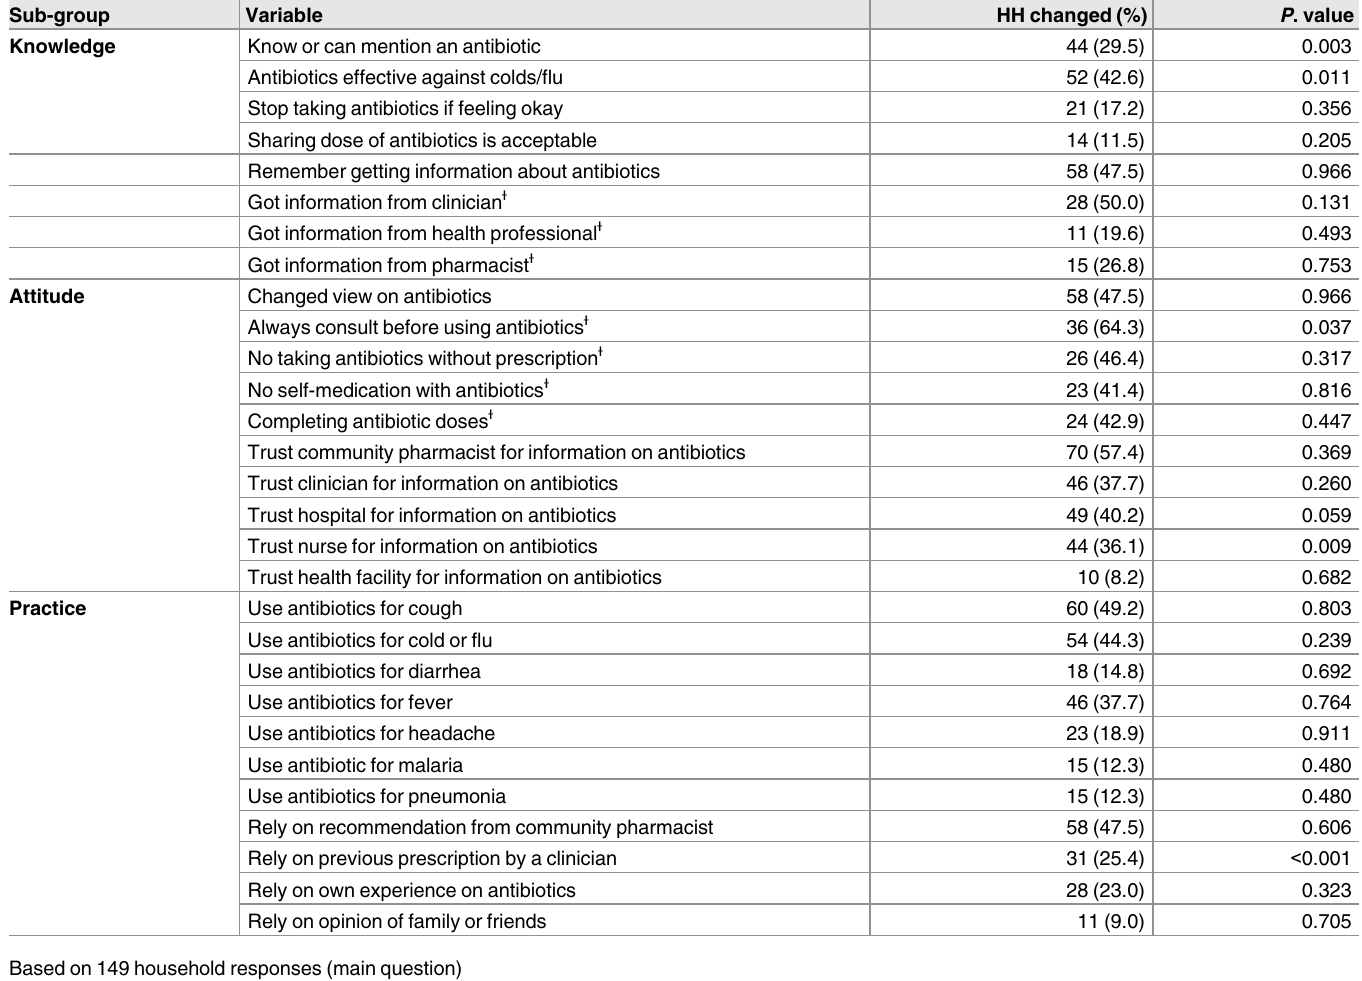
Based on 149 household responses (main question) Ɨ based on 56 householdresponses